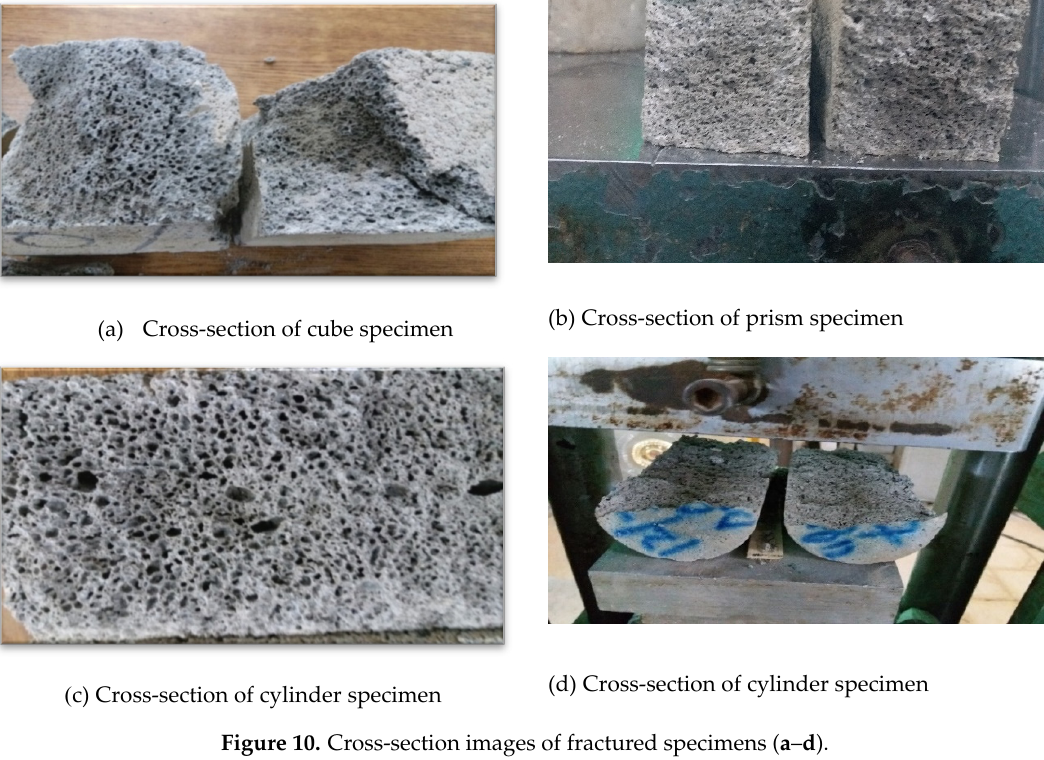
Figure 10. Cross-section images of fractured specimens ( a – d